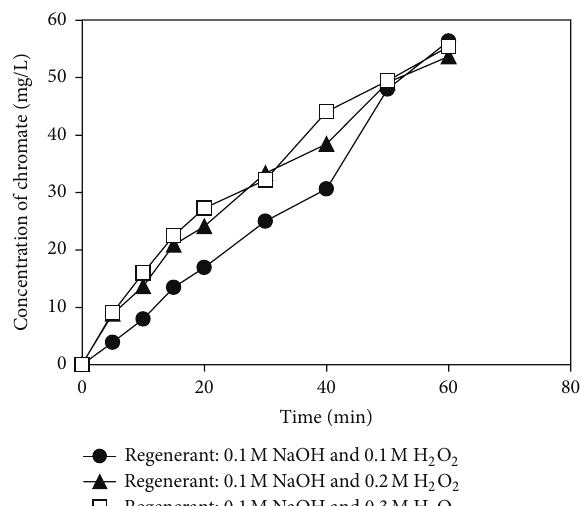
Figure 1: The regeneration efficiency depends on the amount of regenerant solutions. (The amount of exhausted resin: 2.0g; the speed of the stirrer; 200 rev./min; the volume of regenerant solution is 2.0L) (serie I).